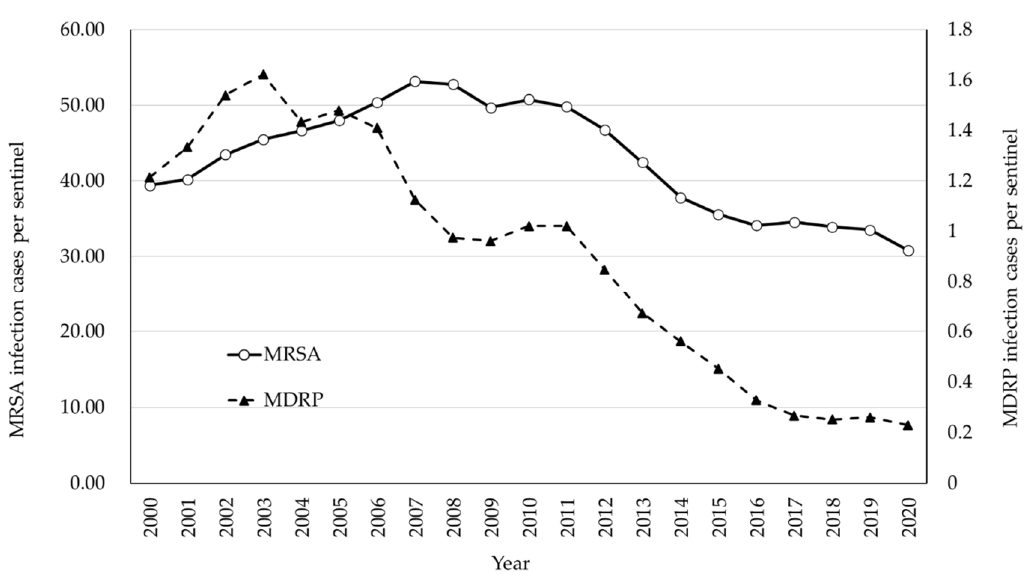
Figure 2. Number of reported cases of MRSA and MDRP infection per sentinel, NESID 2000–2020.